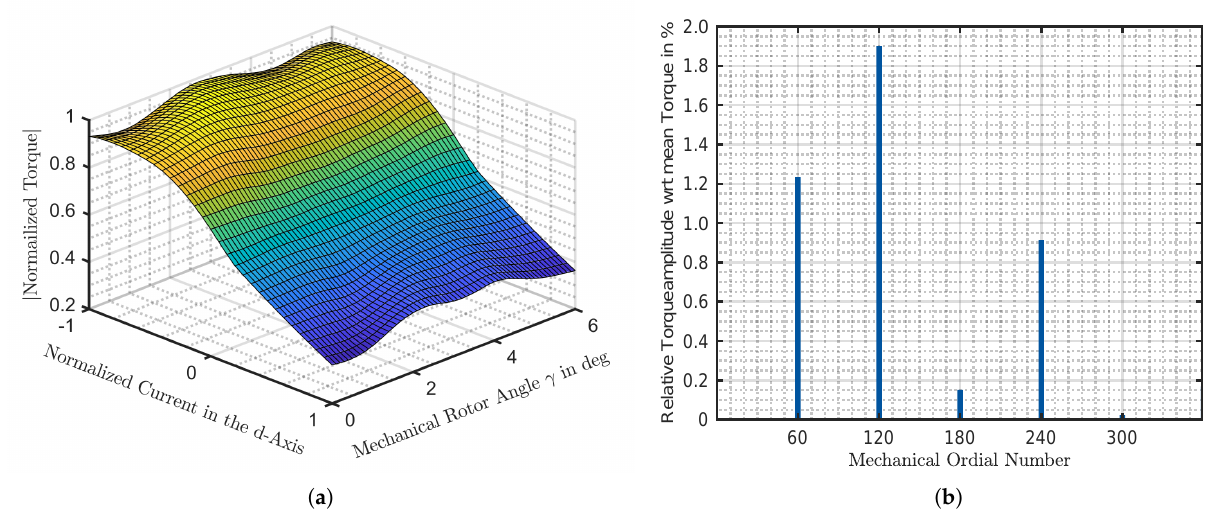
Figure 7. Results of the electromagnetic finite element model: ( a ) Synchronous machine torque as a function of the d-current component and rotor angle; ( b ) Fourier decomposition of the synchronous machine torque for one mechanical